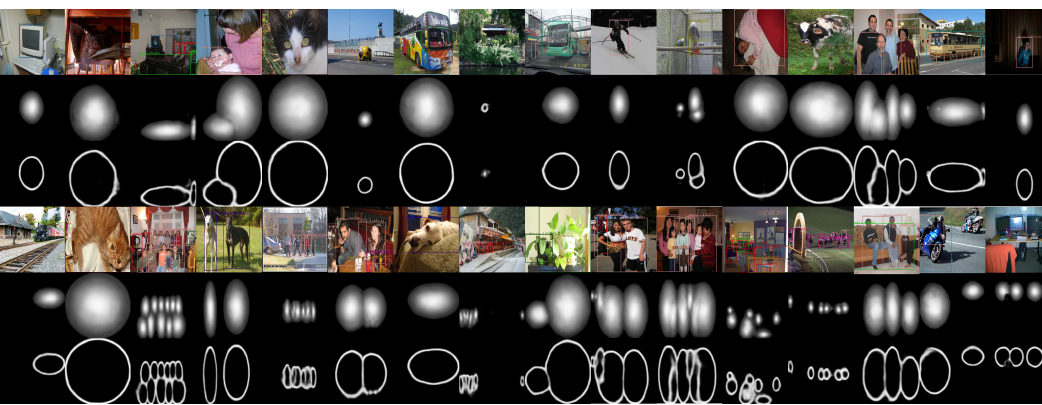
Figure 10. Visualization of detection results in patches of the PASCAL VOC testing set. From top to bottom are two groups of detection results, center fields, and edge fields. For the images with multiple categories corresponding to several object fields, we only demonstrate one of